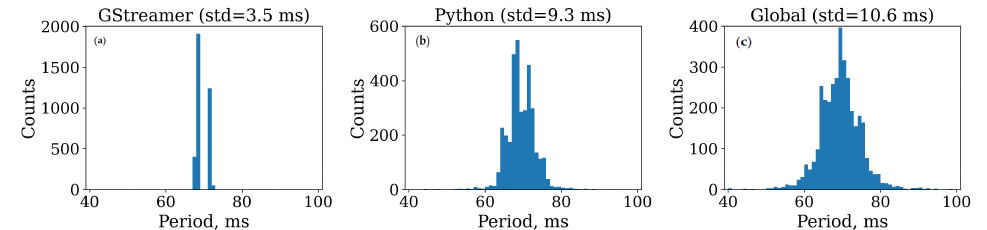
Figure 8. Each frame acquired by the cameras is timestamped three times: ( a ) by the camera driver (GStreamer), ( b ) by the REIP framework (Python), and ( c ) by the microcontroller receiving global timestamps from the master radio (Global). This figure illustrates a progressive degradation of timestamp quality, in terms of jitter, accumulated throughout the data acquisition